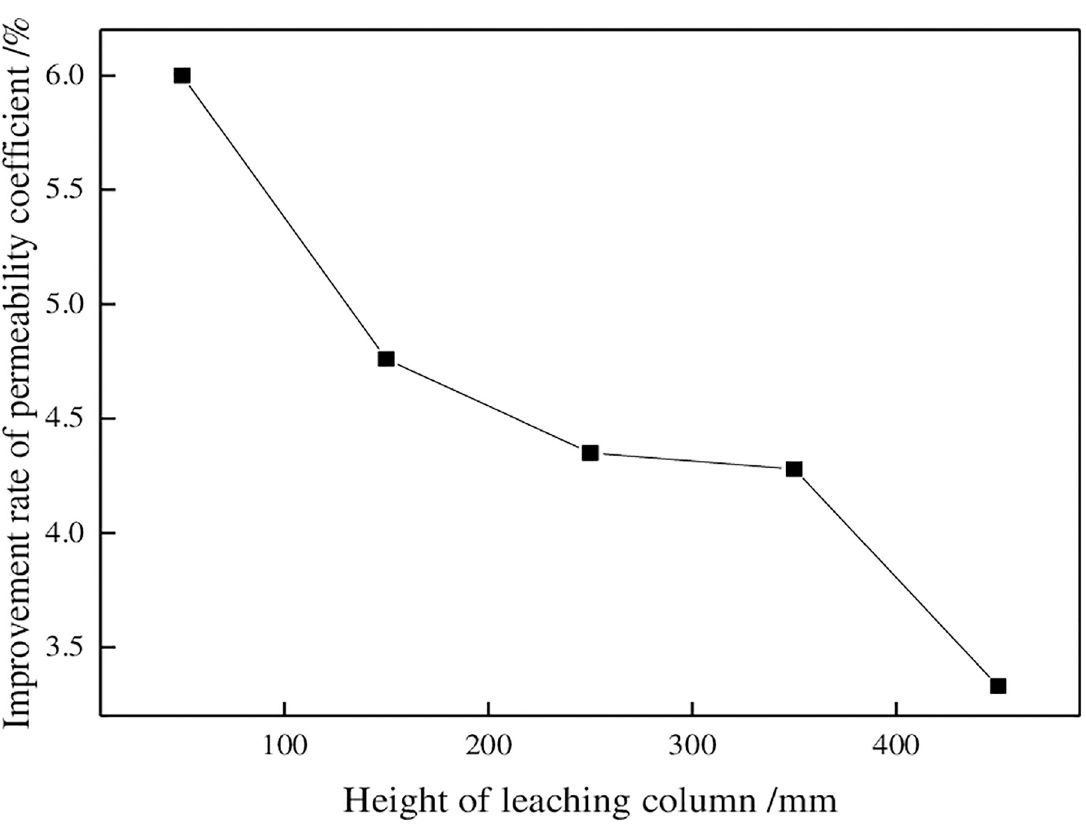
Fig 10. Changes in permeability coefficients with column